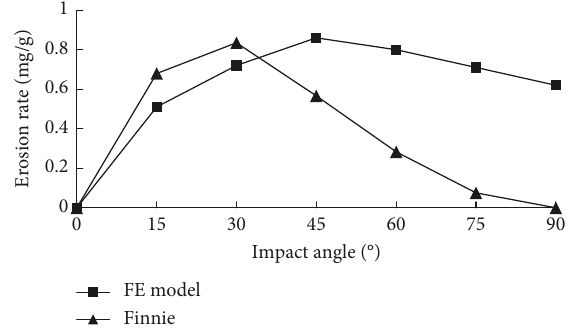
Figure 10: Comparison of simulation results with the Finnie model.